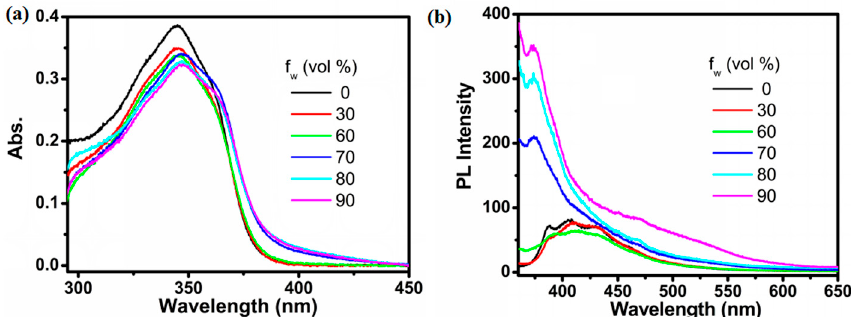
Figure 2. ( a ) Absorption and ( b ) fluorescence emission spectra of compound PPDPD in the THF/water mixtures (10 − 5 mol L − 1 ).